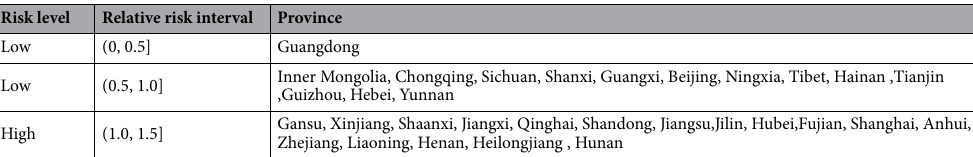
Table 1. Relative risk distribution of spatial effects on level 1 .